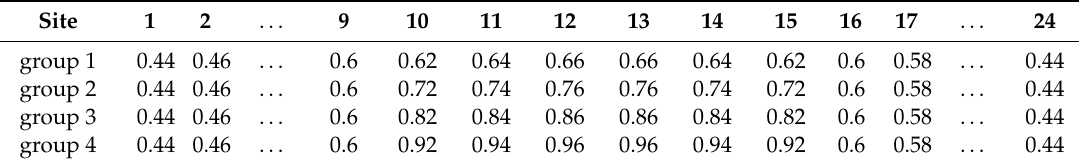
Table 1. Conditional probabilities p kj at each CpG site for simulation of BFM under Scenario 1. Site 1 2